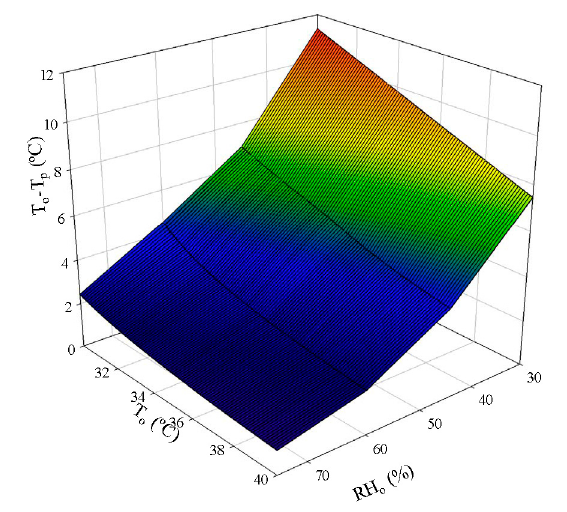
Figure 9. Evolution of the evaporative air cooling on the pad (T o –T p , °C) as a function of the exterior temperature (T, °C) and relative humidity (RH, %) values.